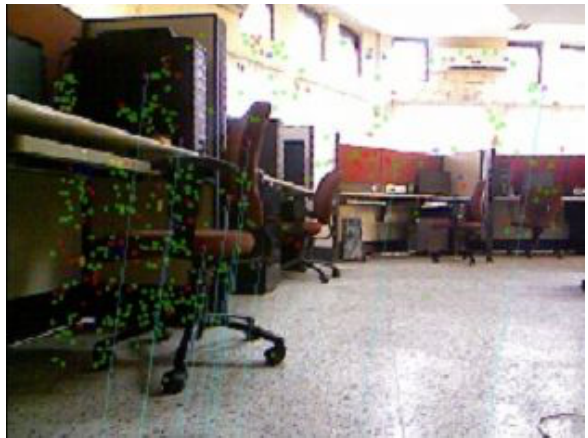
Figure 2: GFTT Features. The green dots show the GFTT feature points detected in our